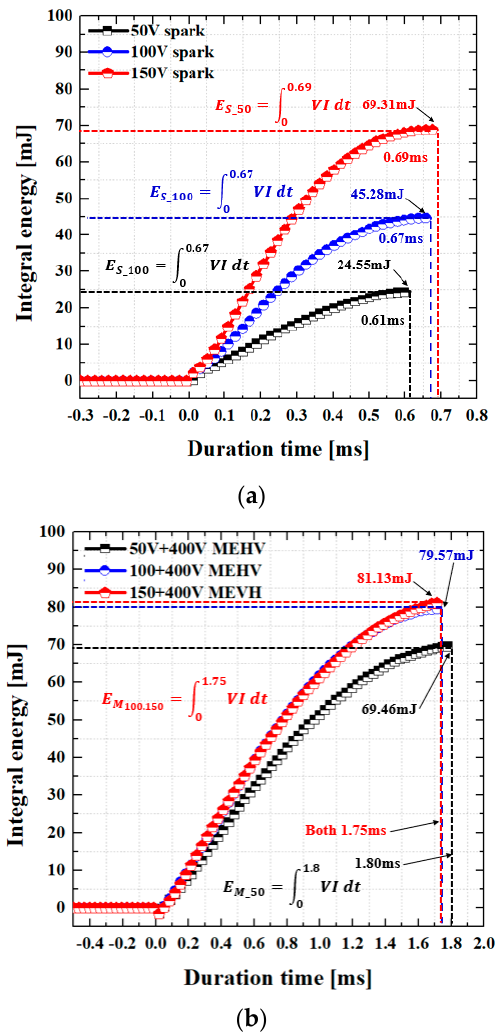
Figure 8. Energy comparison of two different sparks: ( a ) The conventional spark energy; ( b ) MEHV spark energy.